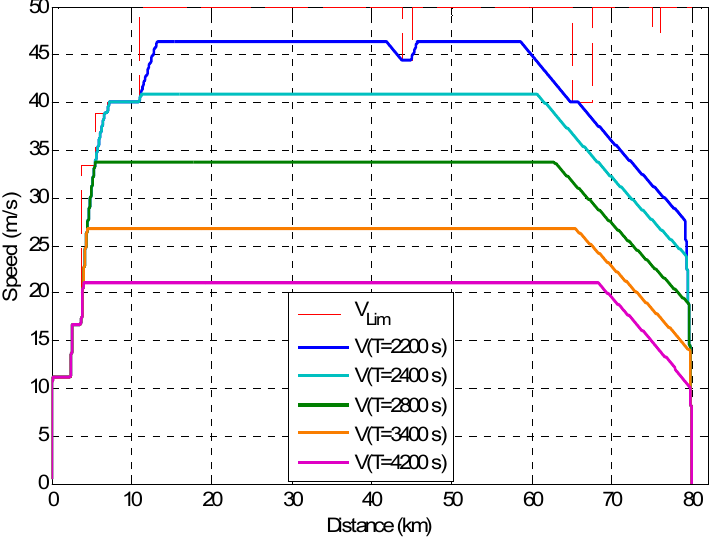
Figure 20. Comparative analysis with Figure 19 using this paper’s proposal.